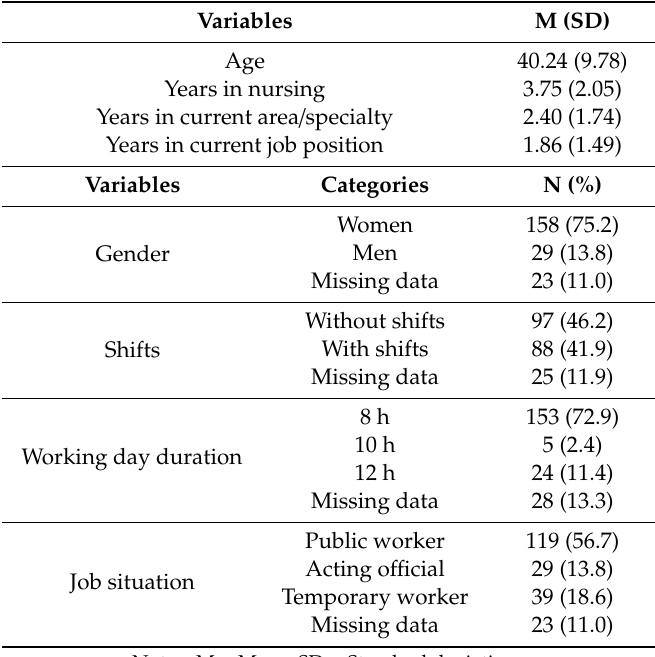
Table 1. Demographic characteristics of the sample.